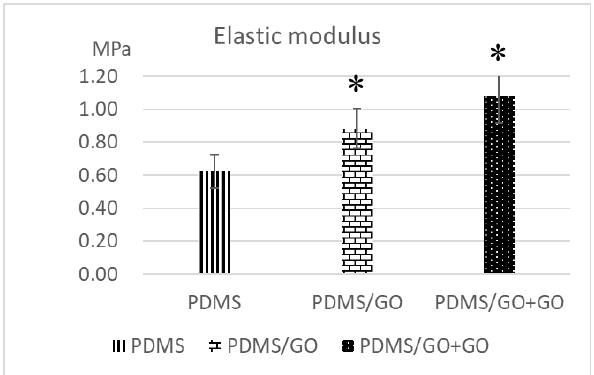
Figure 2. Measurement of elastic modulus of pure PDMS and GO ‐ modified PDMS. The elastic moduli of pure PDMS, PDMS/GO, and PDMS/GO + GO were analyzed by the universal testing machine. The results are the mean ± SD of three independent experiments. * p < 0.05 vs. PDMS.